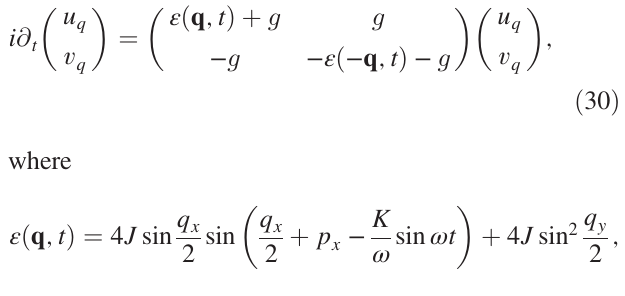
FIG. 10. Numerical instability rate as a function of interaction strength g ¼ U ρ and modulation amplitude K= ω , for ω ¼ 10 J (i.e., outside the low-frequency regime) and for two different numbers of lattice sites in the transverse direction: N 16 (bottom panel) and N y ¼